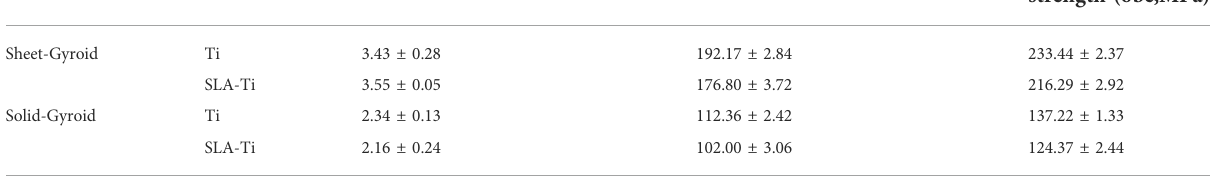
TABLE 5 Results of static compressive